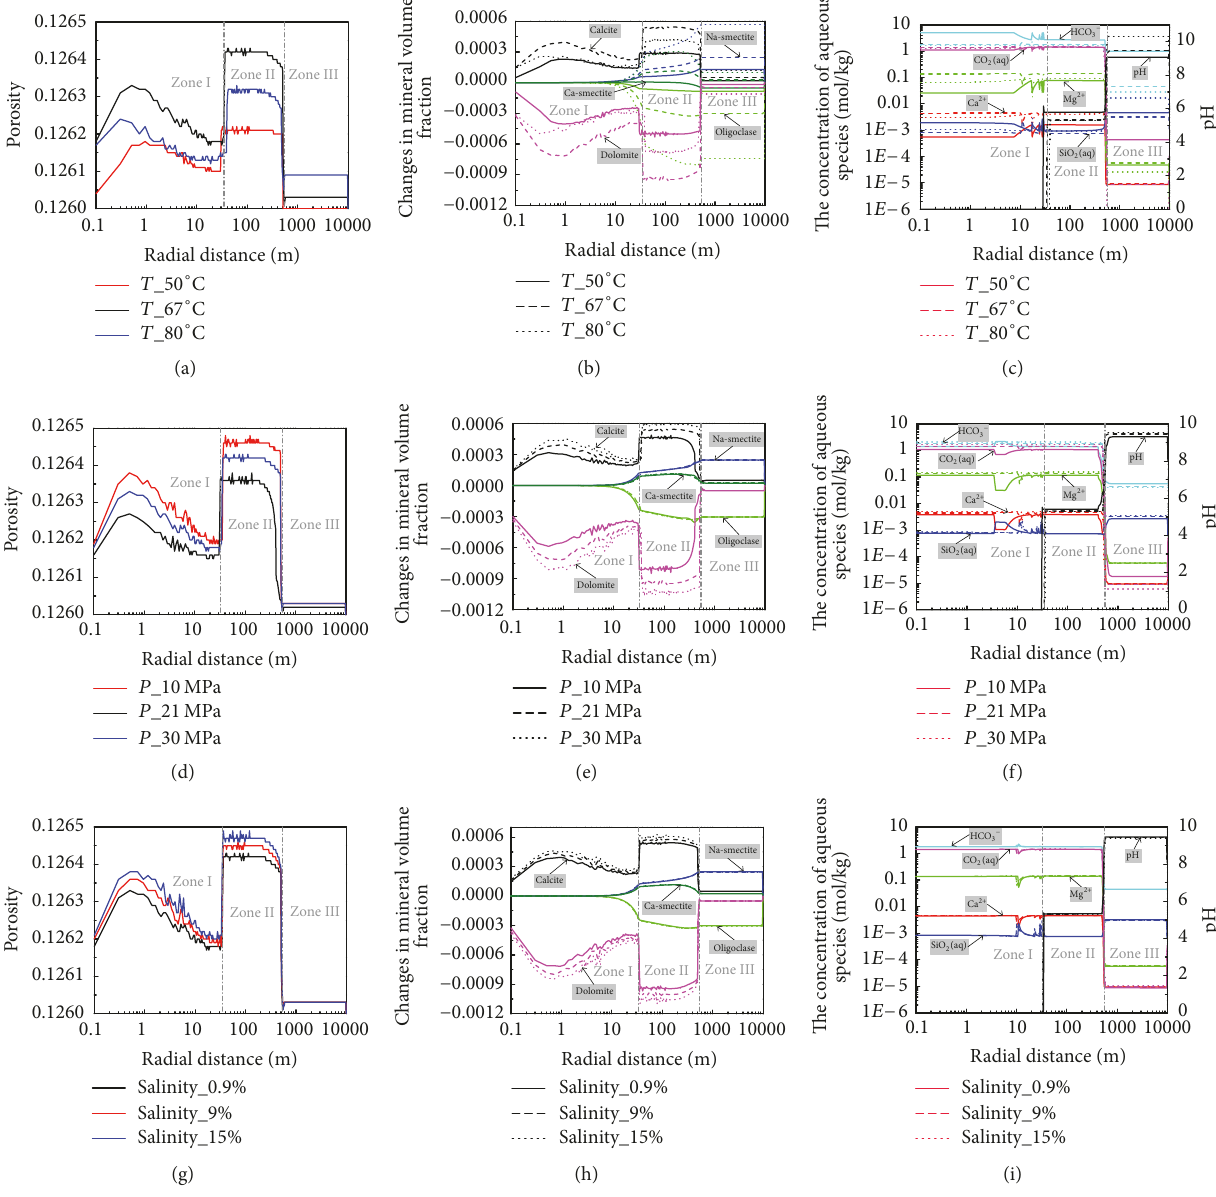
from the dissolution of oligoclase. The effect of temperature on the horizontal distribution of changes in major aqueous species is shown in Figure 5(c), which agrees well with the